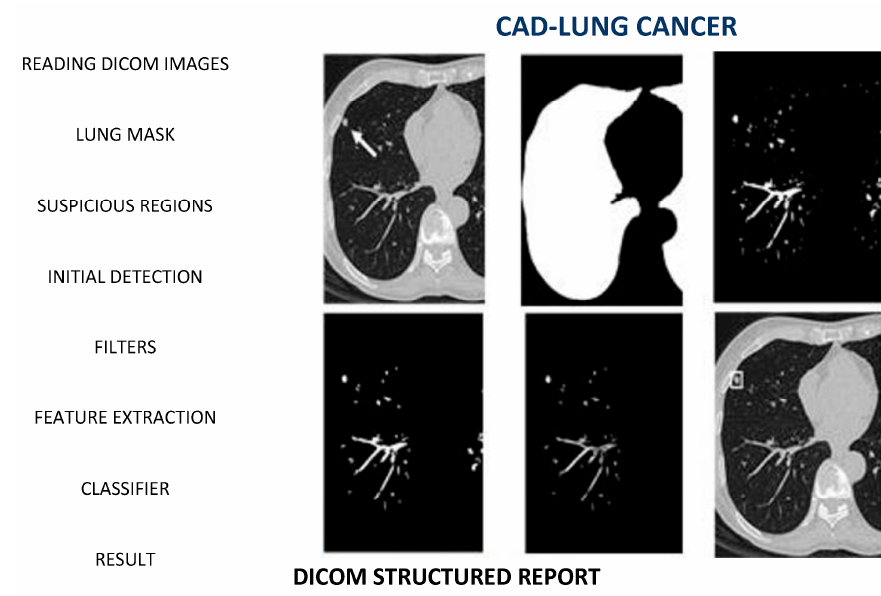
Figure 1. Standard scheme in CAD: From Acquisition to Data analysis [3].